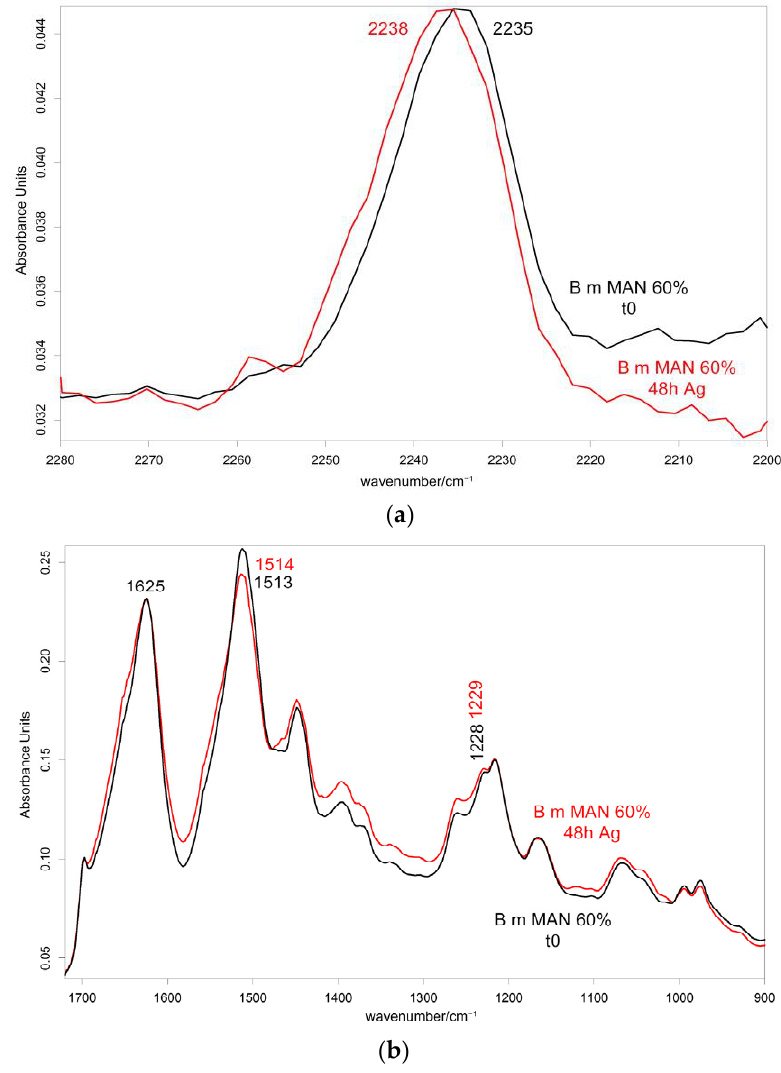
Figure 11. IR spectra recorded in the parallel orientation on the 60% MAN-grafted fibers before and after ageing for 48 h in the Ag + solution in the 2280–2200 cm − 1 ( a ) and 1720–900 cm − 1 ( b ) spectral ranges.